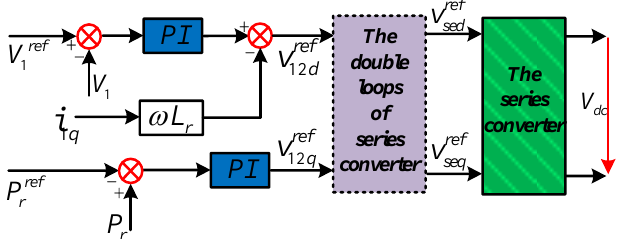
Figure 18. The whole feedforward control scheme of the series converter.